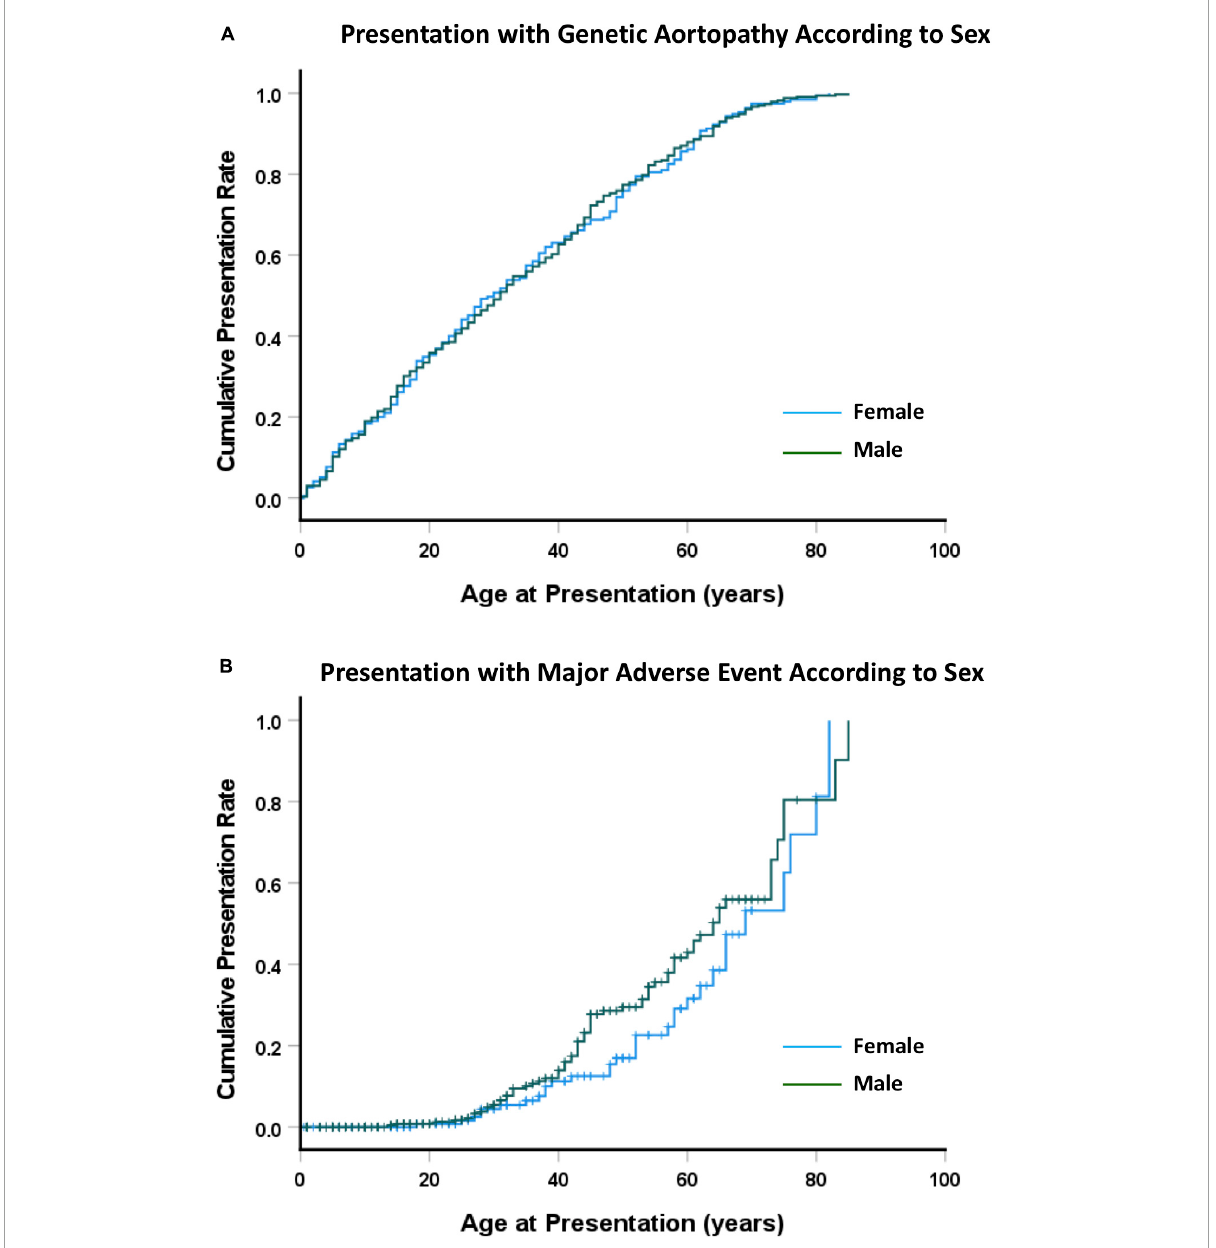
during follow-up in the MFS group, of which 19 occurred after previous aortic root and ascending aorta repair (mean interval 9 years, range 2–18 years). Survival free of dissection, for individuals in follow-up, is compared between groups in Figure 5 . At age 60 years, mean freedom from dissection was: AOS = 80.8 ± 12.6%; LDS = 91.8 ± 5.6%; MFS = 73.5 ± 4.4%; 96.9 ± 1.5% ( p < 0.001).